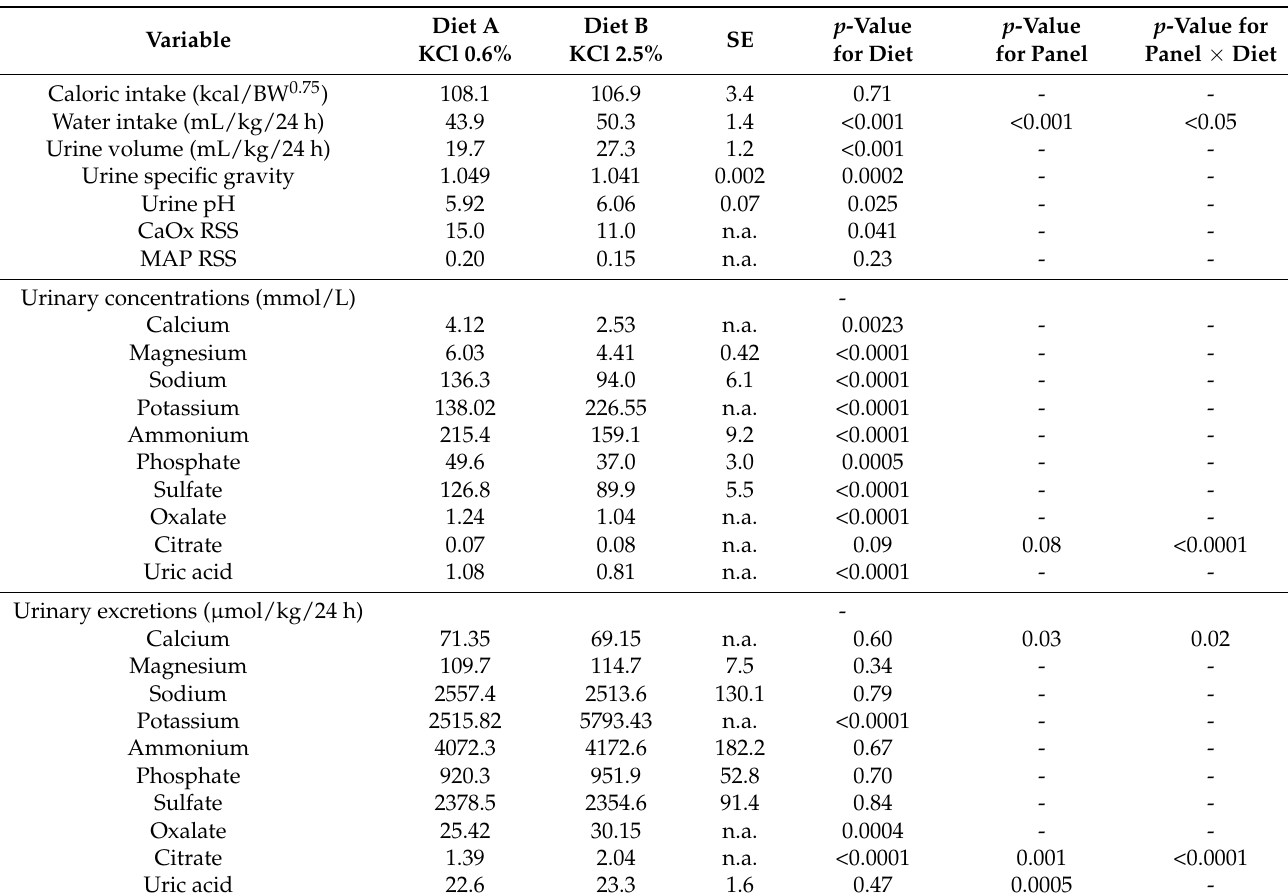
Table 3. Diet and water intakes, and urine variables in dogs ( n = 22) fed the two diets differing in potassium chloride content.